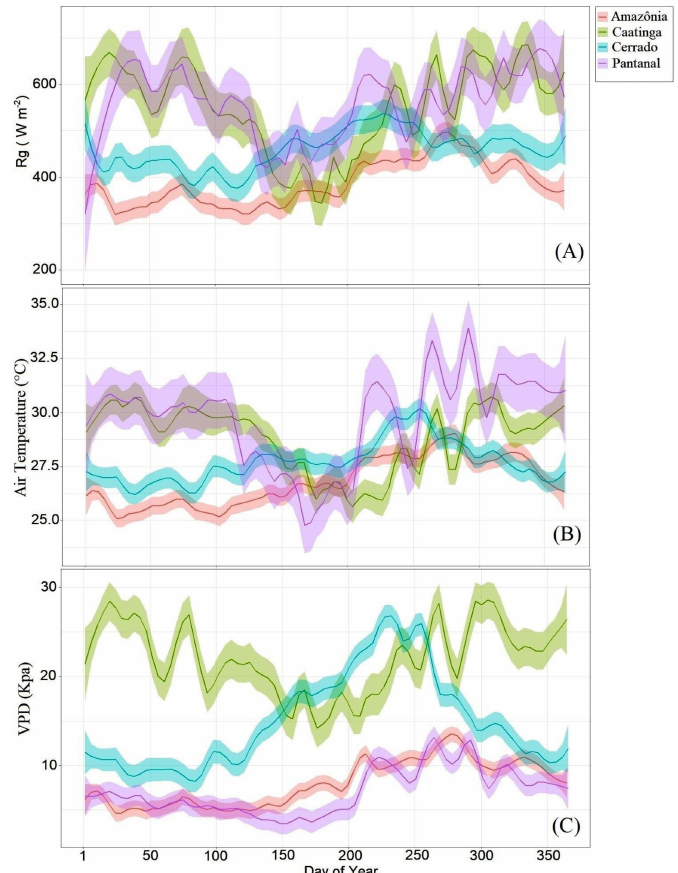
Figure 3. Seasonal variation of the daily mean of meteorological variables: ( A ) global incident radiation (W m − 2 ), ( B ) air temperature ( ◦ C) and ( C ) vapor pressure deficit (kPa). The shaded colored areas indicate data standard